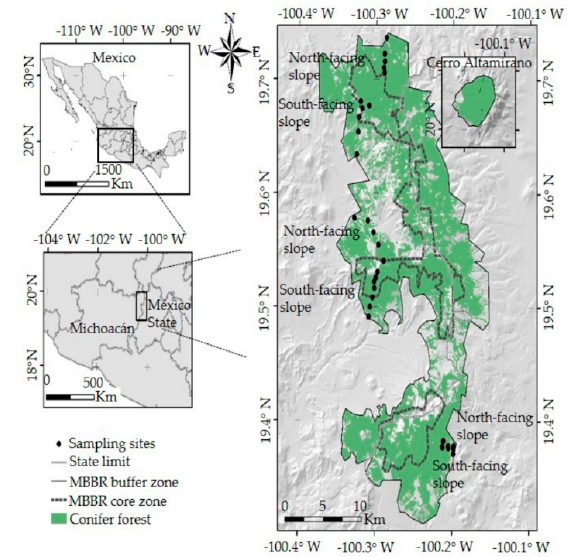
Figure 1. Location of the Monarch Butterfly Biosphere Reserve, central México, and the 32 sampling sites along six altitudinal transects.